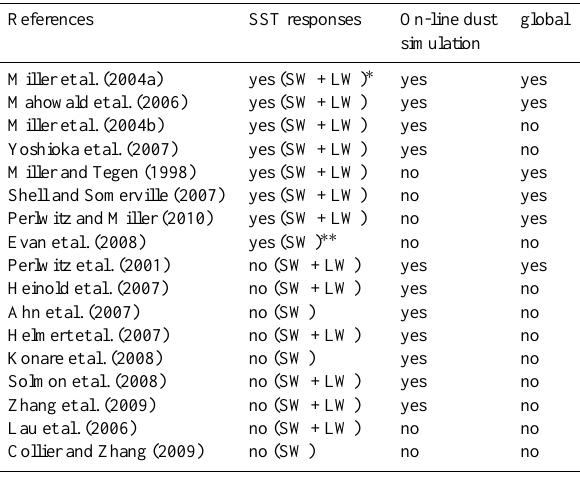
Table 1. Simulations of climatic effect of dust in previous